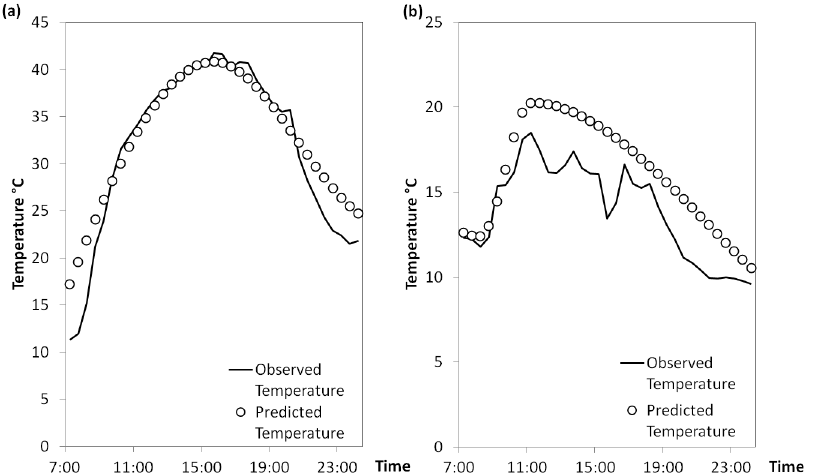
Fig 4. Limitations of the simulated temperature model (STM). (a) Best estimation of half-hourly temperature on a clear day (8 th Feb 2014, Day of the year 39). (b) Worst estimation of half-hourly temperature on a partially cloudy day (21 st Mar 2014, Day of the year 80).